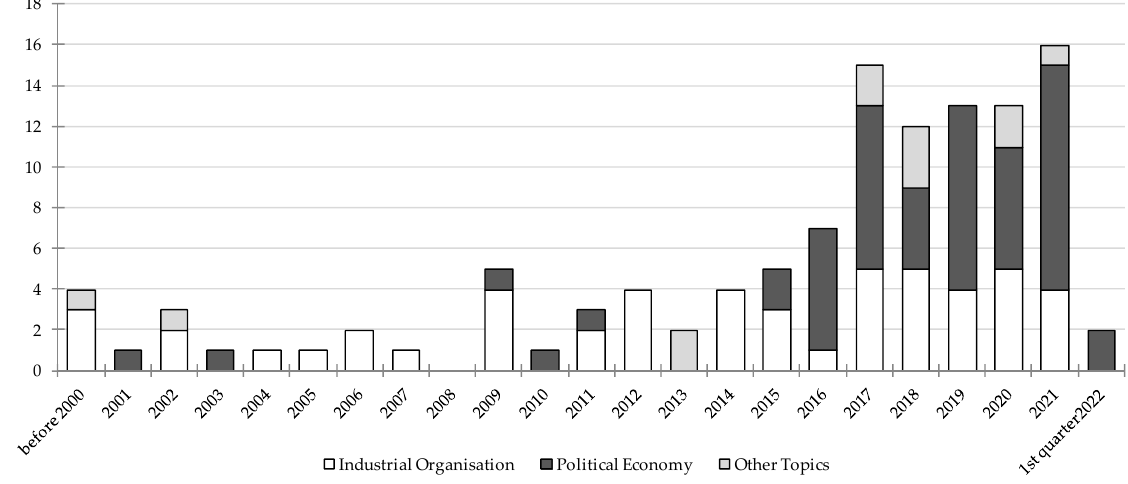
Figure 2. Included studies (116 records)—year of publication and main topics.